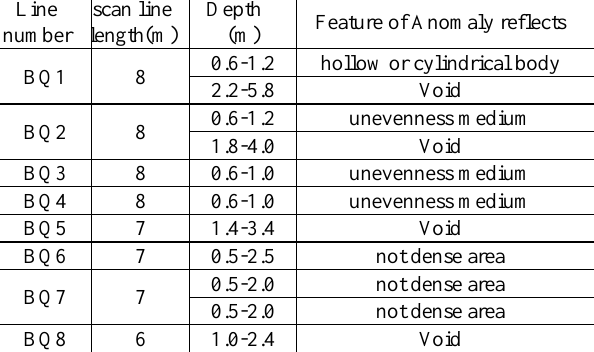
Figure 9. Geological radar map of Beijing Drum Tower north wall Table 1. Anomaly area of Beijing Drum Towers’ north wall